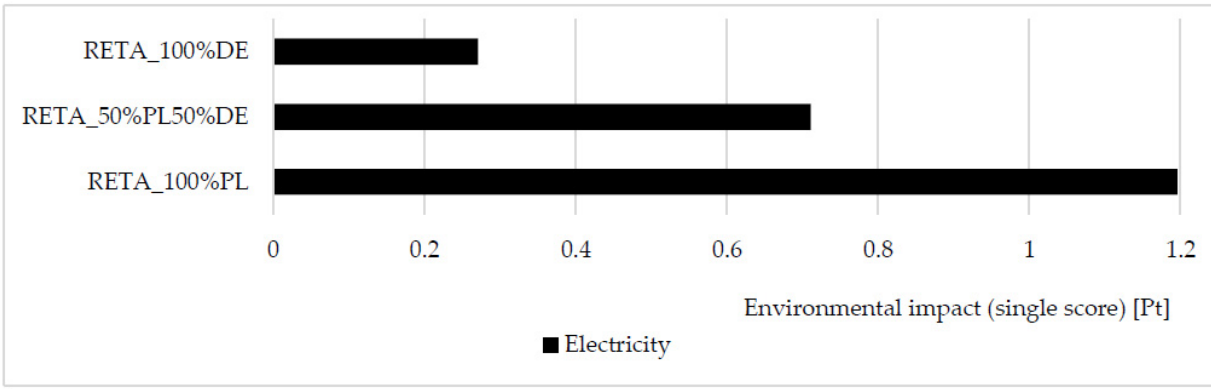
Figure 4. Environmental impact of the life cycle stage Retail (RETA) per 1 refrigerator (0.271 Pt = 100%DE, 0.711 Pt = 50%PL50%DE, 1.196 Pt = 100% PL, decrease by 77%).